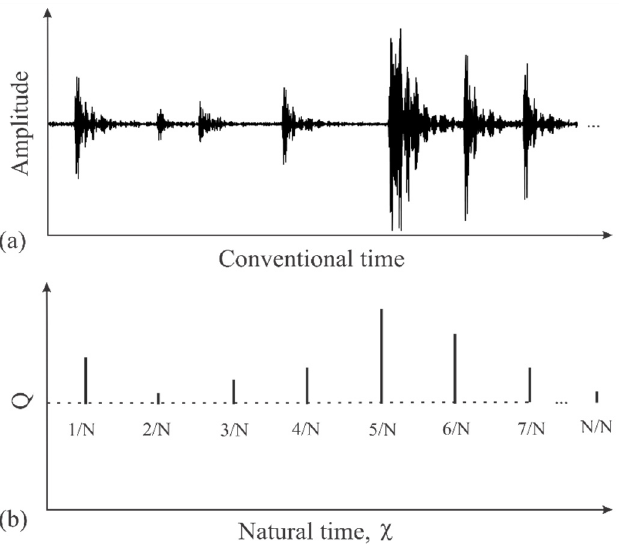
Figure 2. The NT analysis method: ( a ) a typical AE time series; ( b ) corresponding NT representa- tion.